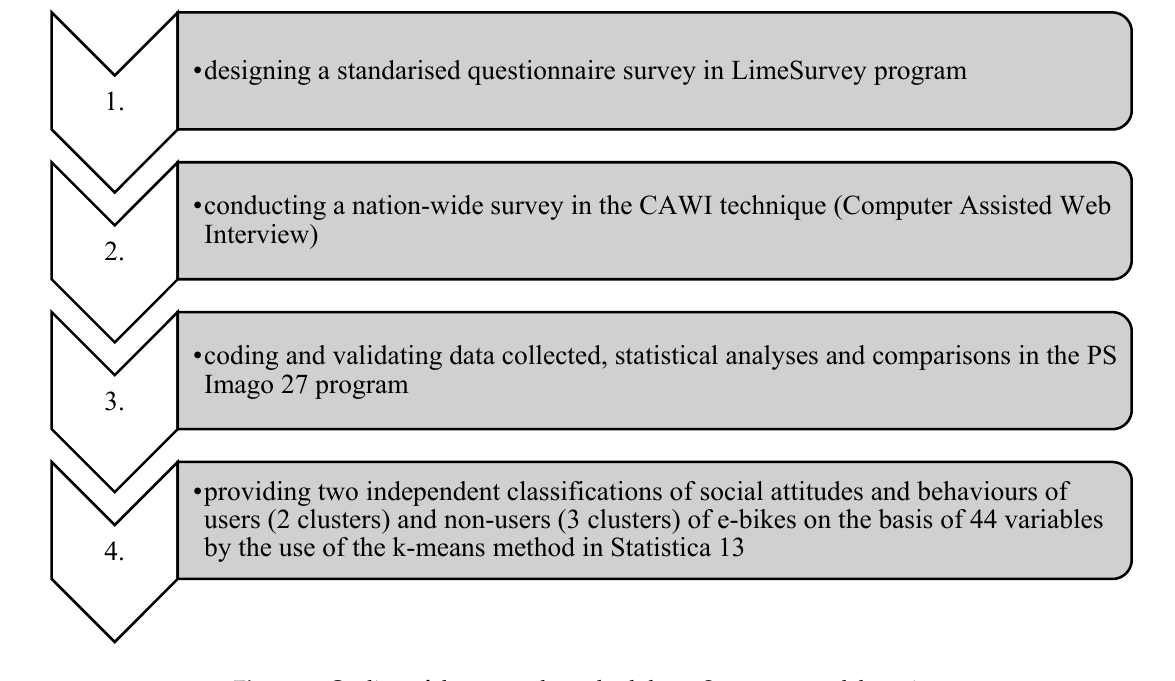
Figure 1. Outline of the research methodology. Source: own elaboration.